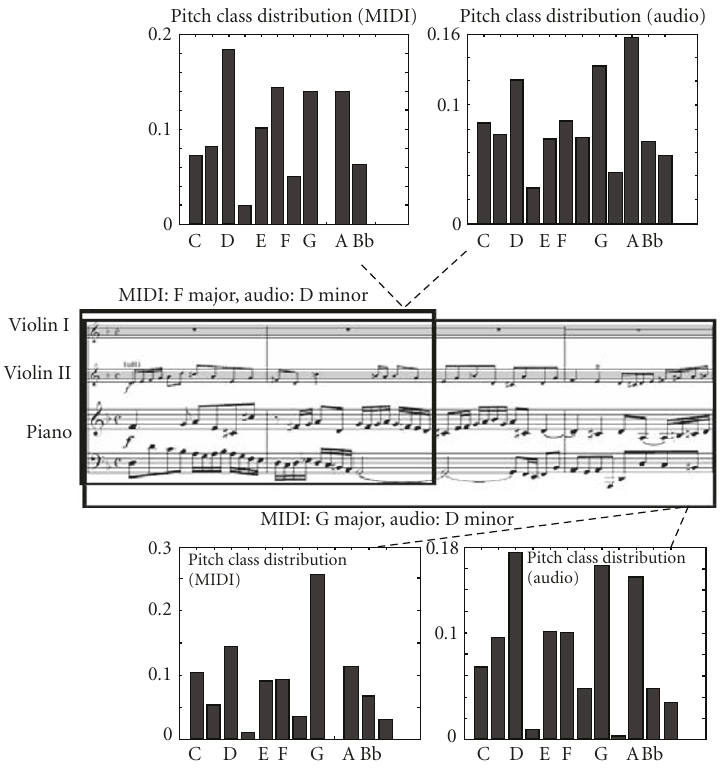
Figure 4: Pitch-class distribution of Bach concertos in D